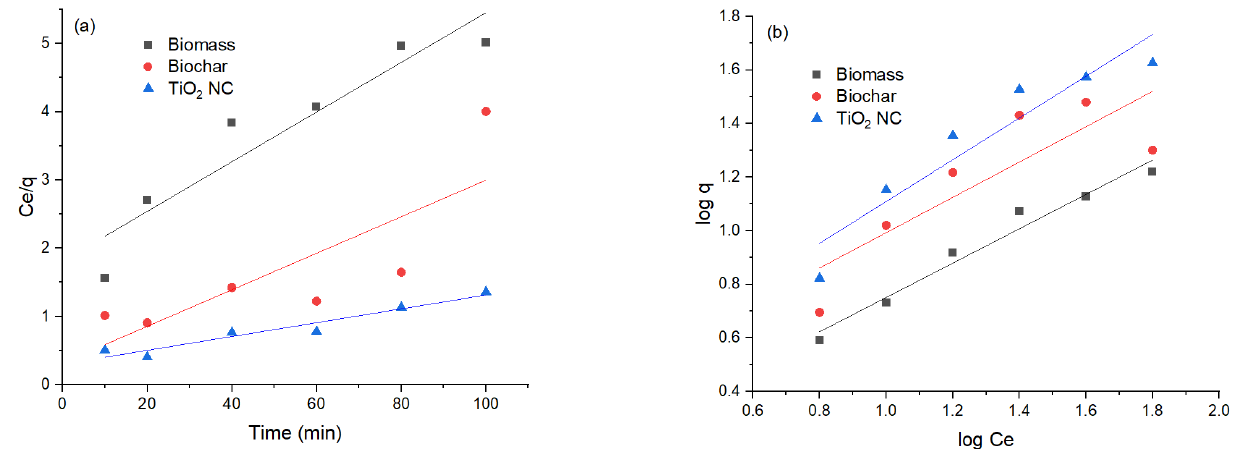
Figure 9. ( a ) Comparison of Langmuir isotherm; ( b ) Freundlich isotherm of lead adsorbed.